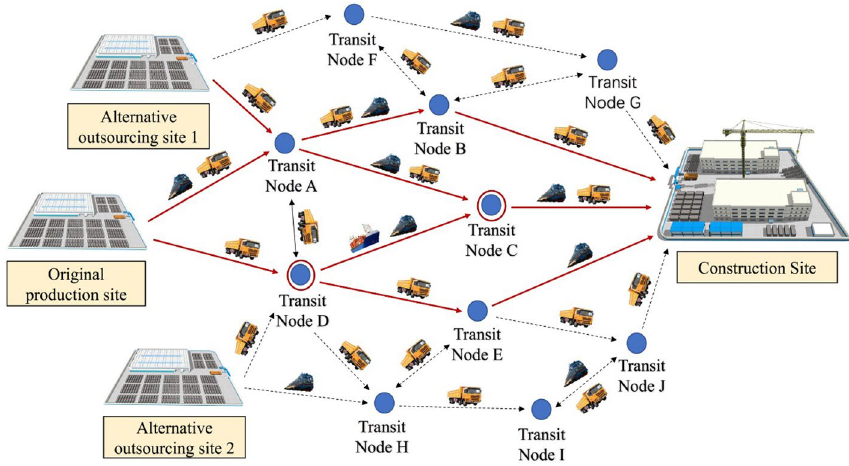
Figure 9. A resilience-cost tradeoff PCSC plan for the precast construction project Table 4. Detailed description of the